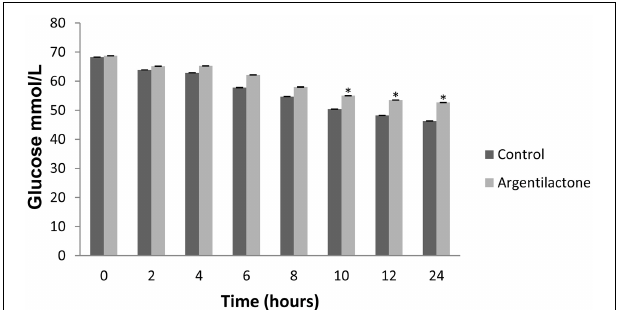
FIGURE 5 | Glucose quantification. The level of glucose was quantified by enzymatic kit after 0, 2, 4, 6, 8, 10, 12 and 24h. The control was performed with cells in the absence of argentilactone. The Student’s t -test was used for statistical comparisons, and the observed differences were statistically significant ( * p ≤ 0 . 05